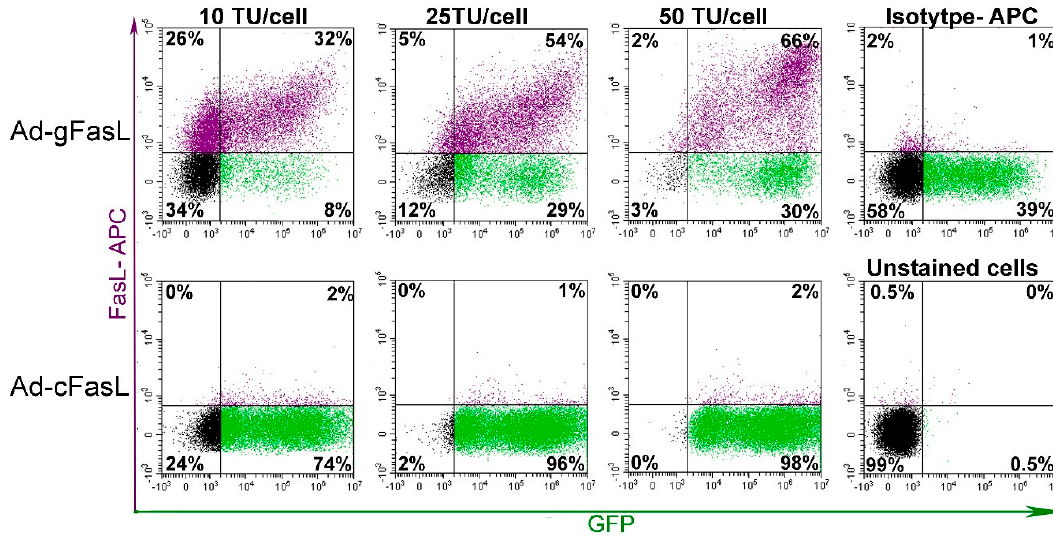
Figure 3. FasL expression in transduced bovine aortic endothelial cells: Cells were transduced with increasing adenoviral titers in the range of 10–50 transduction units (TU) per cell. The cell surface expression of FasL protein was assessed using anti-CD95L antibodies (MFL4 clone) along with intrinsic fluorescence of green fluorescent protein (GFP). Effective induction of FasL expression was observed only for cells transduced with a vector encoding the minigene (Ad-gFasL), whereas only GFP expression was detected following transduction with a vector encoding cDNA (Ad-cFasL).